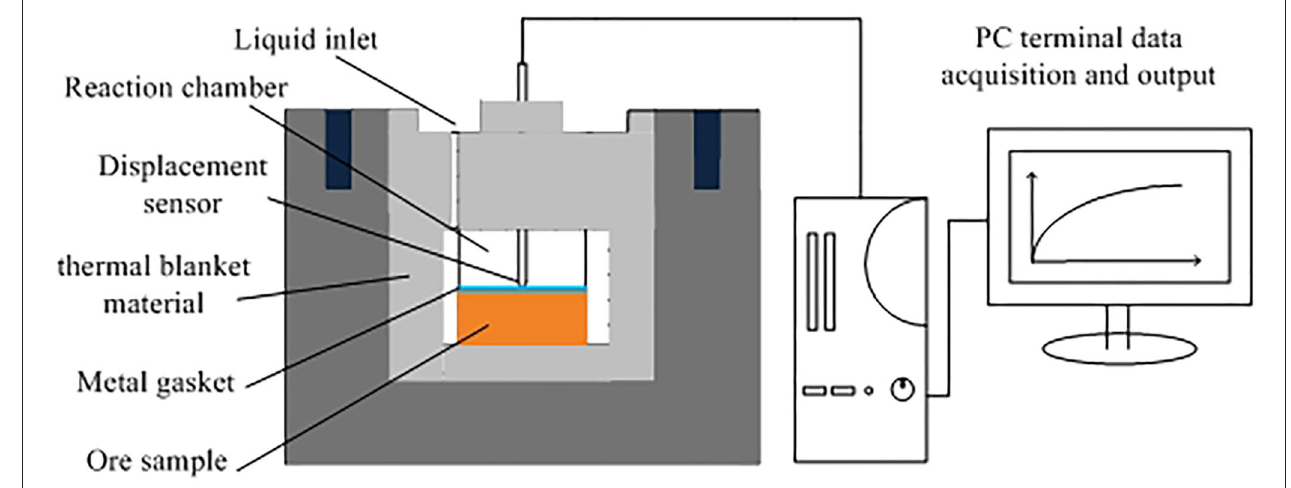
FIGURE 3 | PCY intelligent dilatometer.